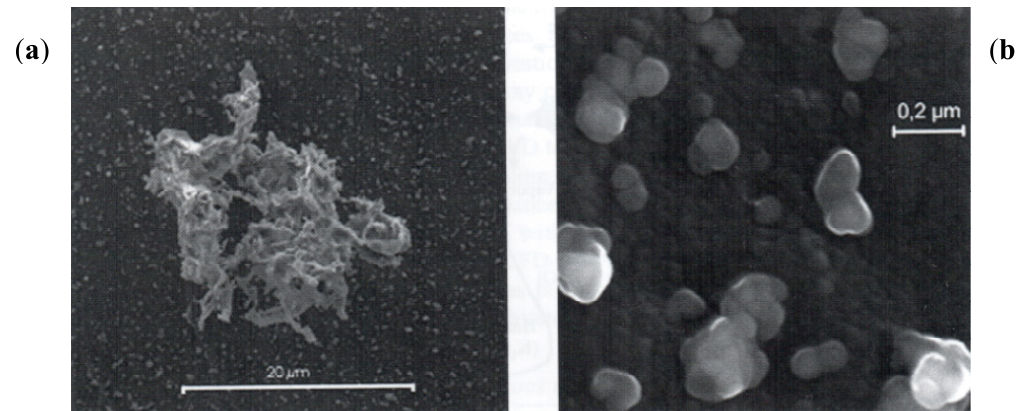
Figure 2. SEM-EDX images of coarse fly ash ( a ) and aerosol particles ( b ) from wood combustion in a grate furnace